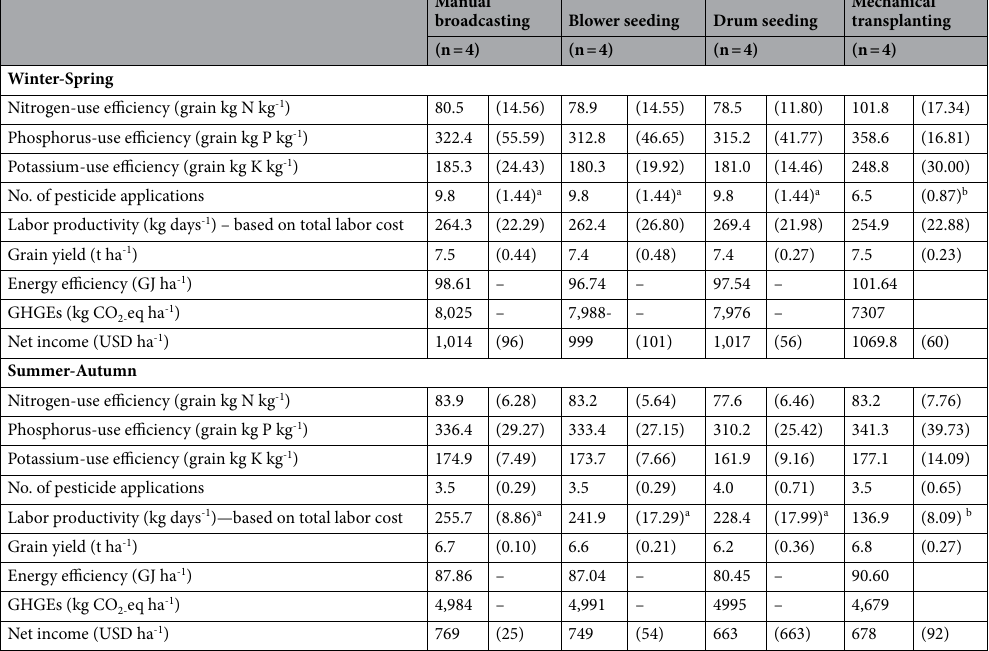
Table 5. Sustainability performance indicators (mean values followed by standard error in parentheses) of crop production across the four field trial treatments in the WS and SA seasons in Can Tho, Vietnam. Within a particular row, numbers followed by different letters are significantly different by least significant difference at α = 0.05.